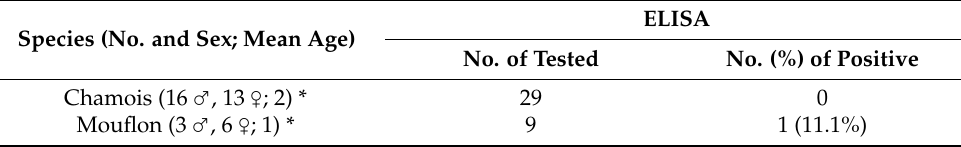
Table 1. Results of detection of specific antibodies against MVV/CAEV using ELISA in serum samples from wild small ruminants in Slovenia. Species (No. and Sex; Mean Age)